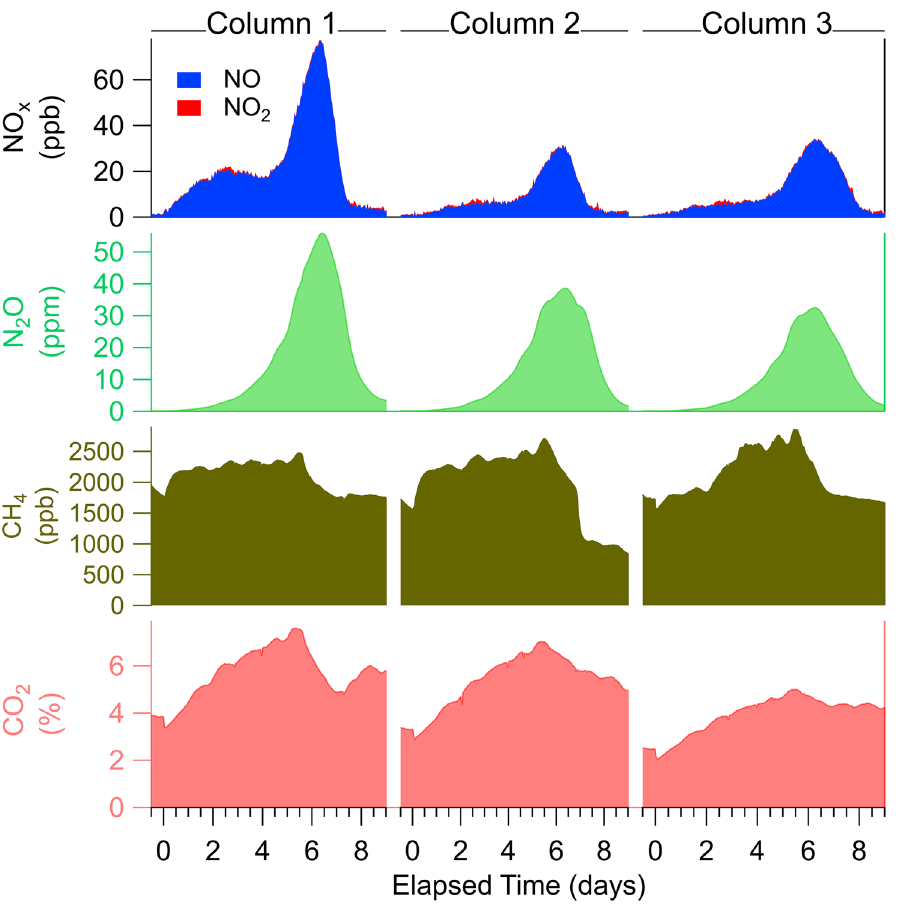
Figure 2. Temporally resolved subsurface gas concentrations show dynamic, reproducible responses to nitrogen fertilizer addition (at time zero) in three replicate soil columns of Experiment 1. Total NO x (top panel) is the sum of NO (blue) and NO 2